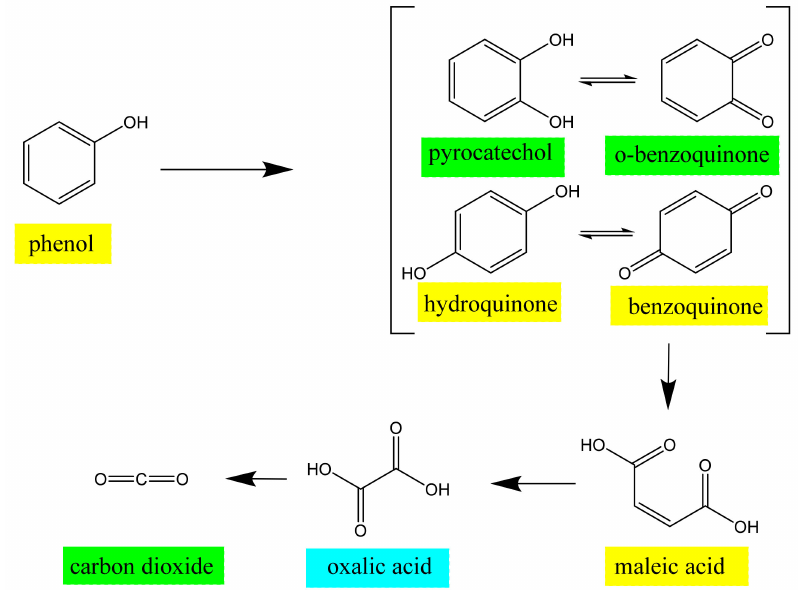
Figure 6. Mechanism of electrochemical oxidation degradation process of phenol, proposed on the basis of our NMR data and previous reports [32,33]. The chemical species highlighted in yellow were observed in this study, those highlighted in cyan was validated in an ex situ EC experiment, and those highlighted in green in previous studies using other analytical